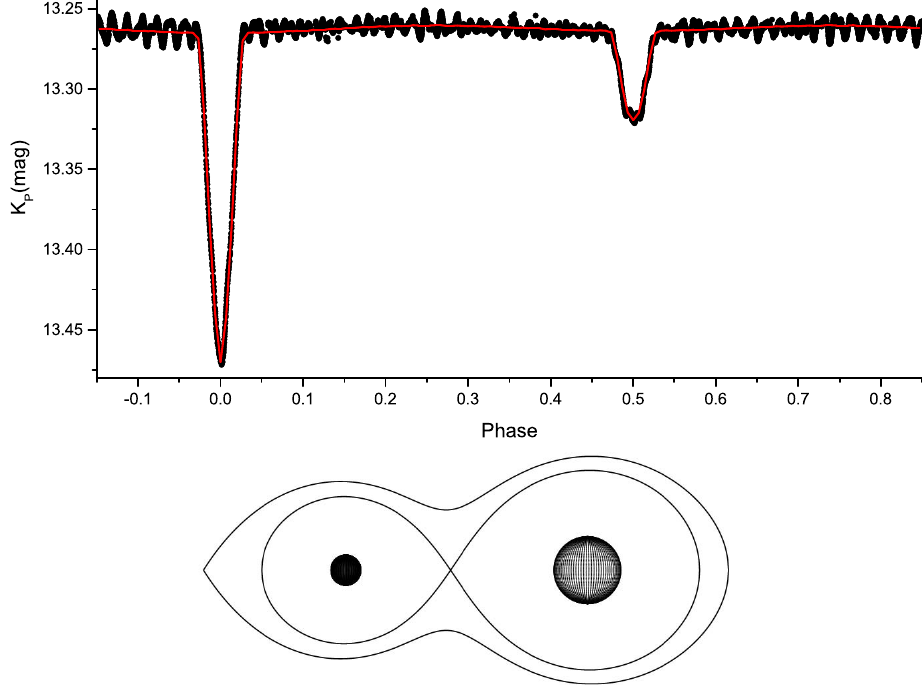
Figure 5. Example of LC modelling (solid lines) over the observed Kepler LCs (points) of an individual orbital cycle and the Roche geometry plot (the right star is the primary component) at orbital phase 0.75 for KIC